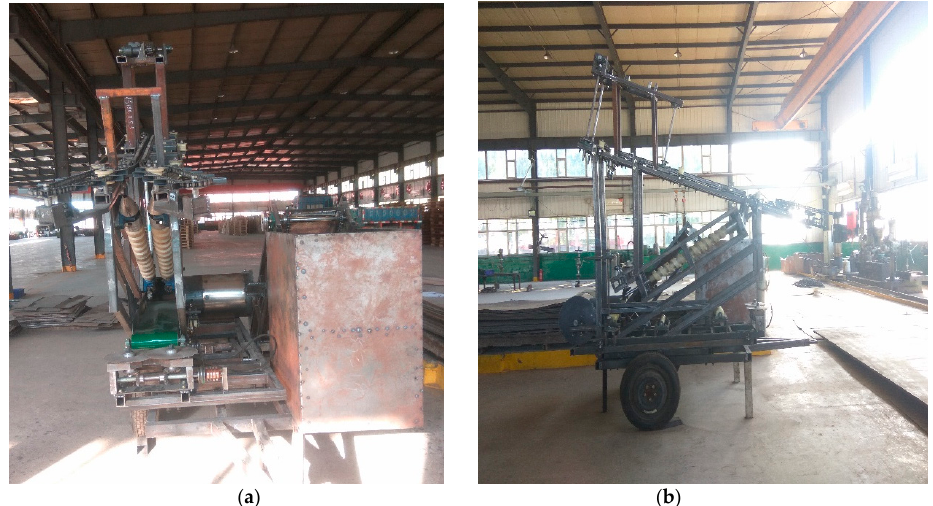
Figure 9. Bionic reverse picking header prototype. ( a ) front view; ( b ) side view.